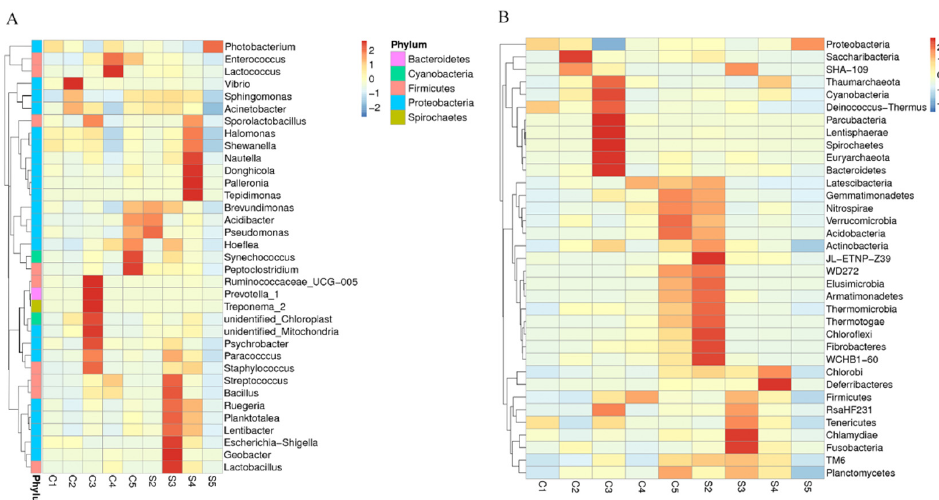
Figure 6. Heatmap at the genus ( A ) and phylum ( B ) level of the of control and treatment groups. The horizontal axis shows the sample information, and the vertical axis shows the species annotation information. The species clustering tree is on the left.